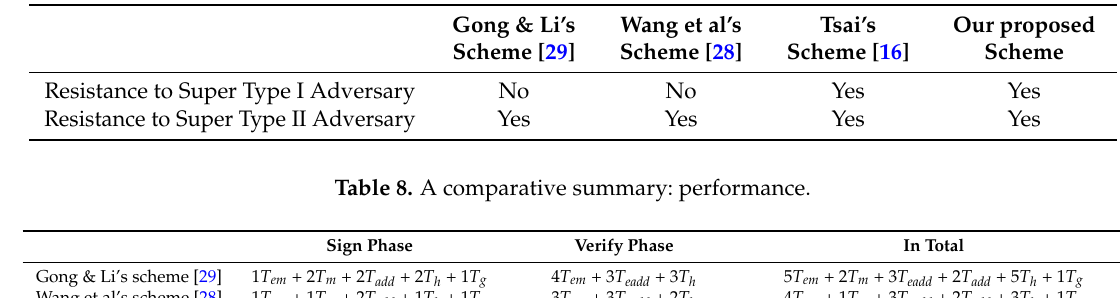
Table 7. A comparative summary: security.